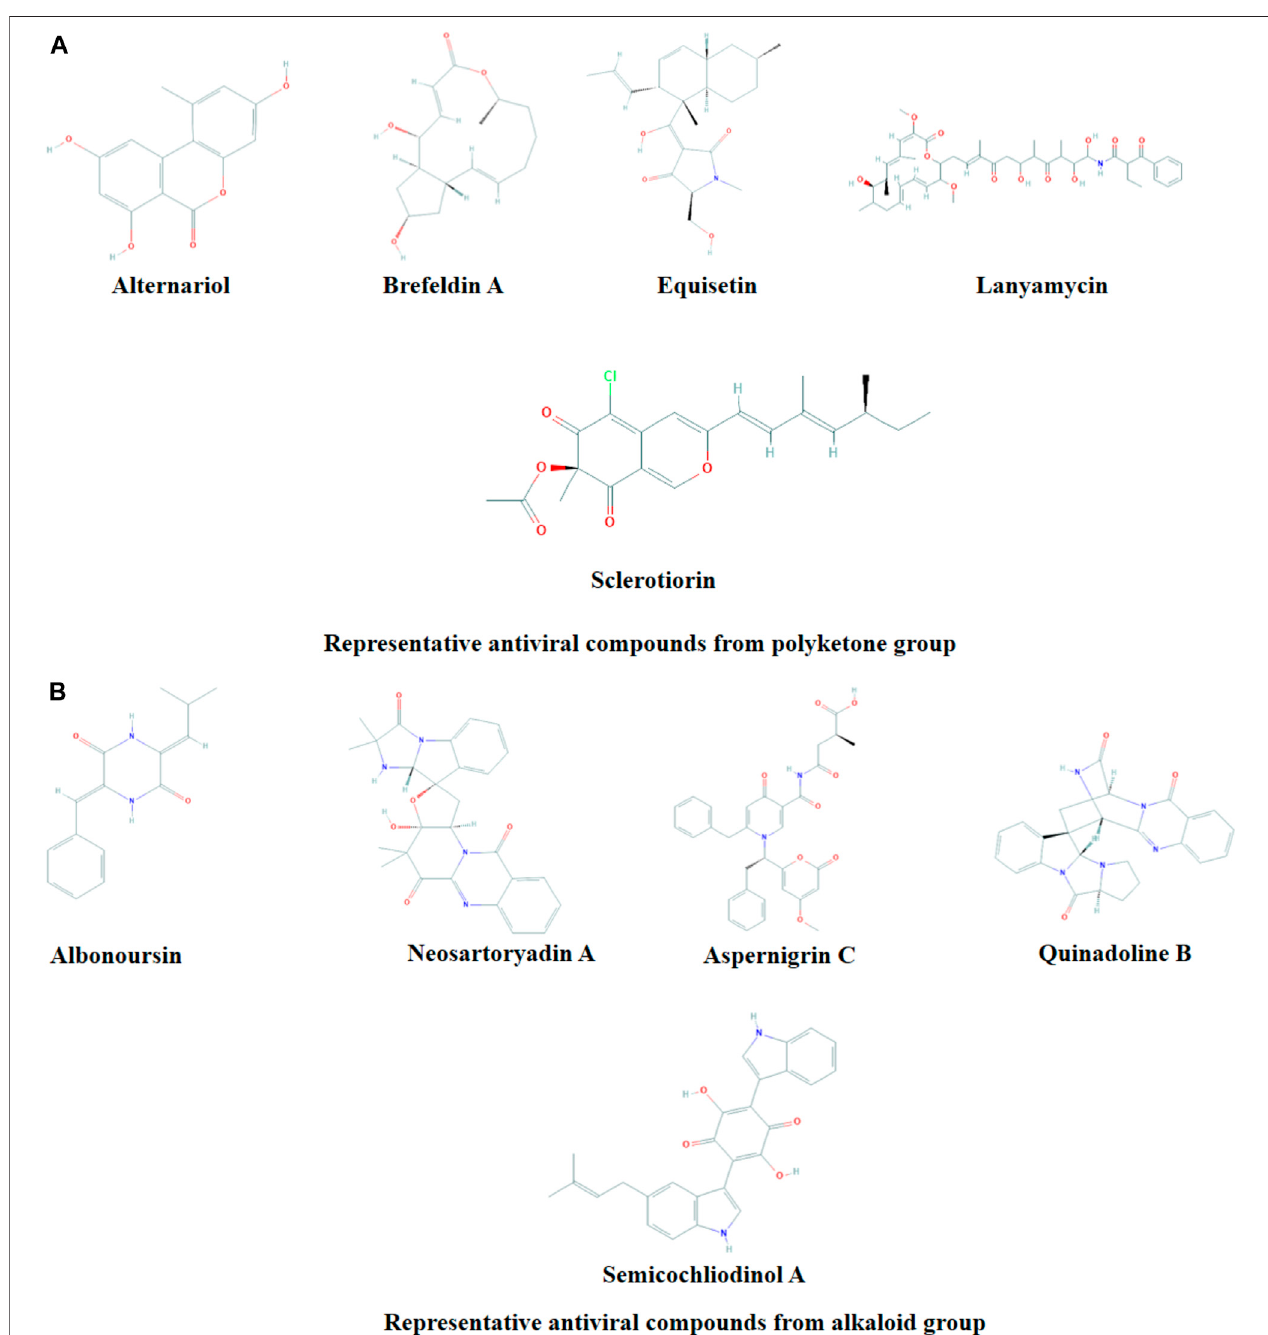
FIGURE4| Representativeantiviralcompoundsfrompolyketone (A) ,alkaloid (B) ,peptide (C) ,polyphenol (D) ,pyrone (E) ,quinone (F) ,sterol (G) ,andterpenoid (H) groups.